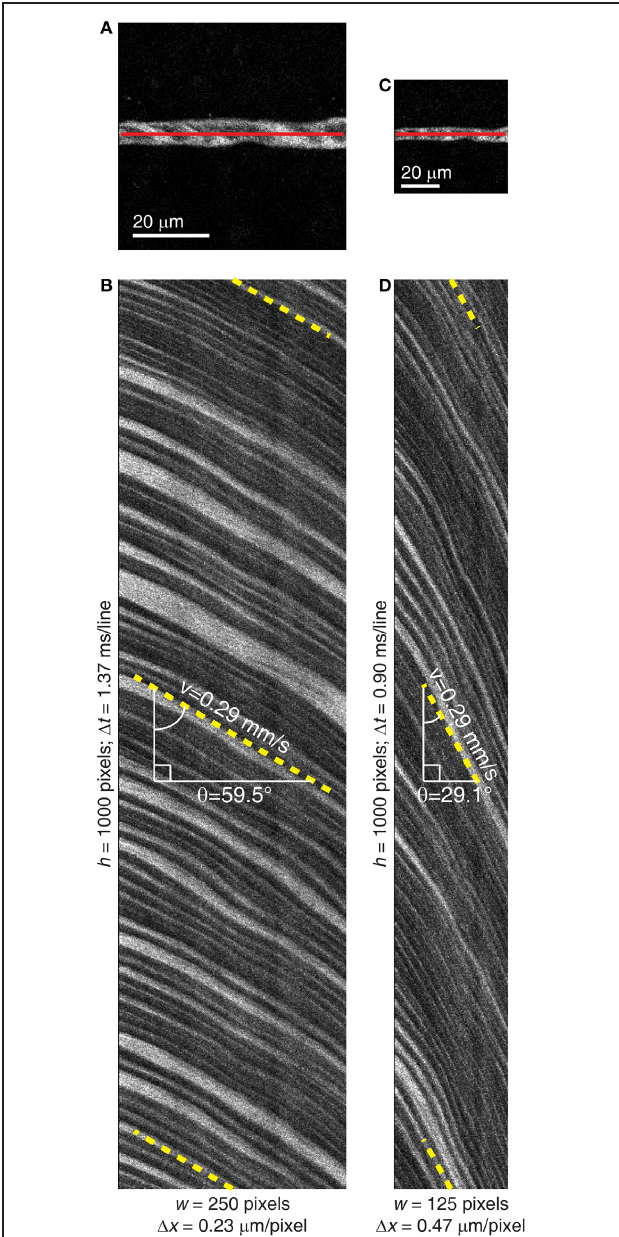
FIGURE 2 | Change in the pixel resolution leads to change in the RBC streak angle. (A) Full-frame image of an 8 μ m diameter microvessel segment in the rat visual cortex with the line-scan trajectory shown as a red line. (B) Space-time image collected from the vessel shown in (A) . Line-scan imaging with spatial resolution ( (cid:2) x ) of 0.23 μ m/pixel and period ( (cid:2) t ) of 1.37ms/line was used. Pixel dwell time was 4 μ s. The RBC streaks have angle of 59.5 ◦ (dashed yellow lines) and blood velocity of 0.29mm/s. (C) Full-frame image of the same microvessel segment as shown in (A) but with coarser spatial resolution. (D) Space-time image collected with the same line-scan path but with bigger pixel size ( (cid:2) x = 0 . 47 μ m/pixel) leading to shorter line-scan time ( (cid:2) t = 0 . 9ms/line). This resulted in the RBC streak angle of 29.1 ◦ (dashed yellow lines) and blood velocity of 0.29mm/s. The mean ± SD velocity from the acquired 20 line-scan images was 0 . 28 ± 0 . 02mm/s in (A) and 0 . 29 ± 0 . 02mm/s in (C) ( p = 0 . 54, two-sample t